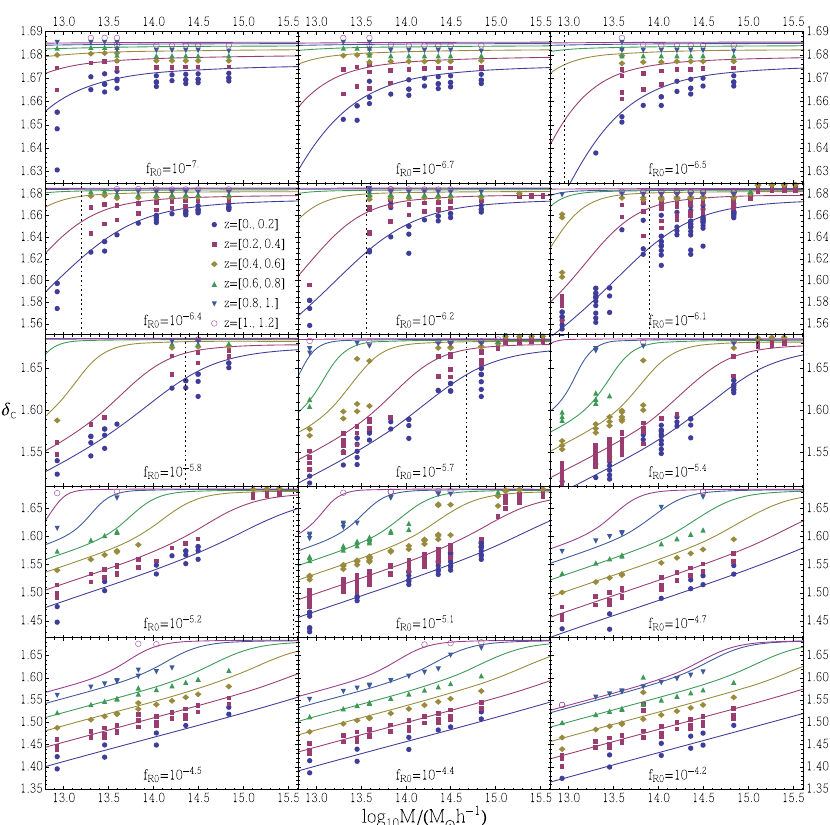
Fig. 9 δ c as a function of mass. In each panel we show the results from the numerical analysis (points) and from the fitting function (lines). Image reproduced with permission from Kopp et al. (2013), copyright by